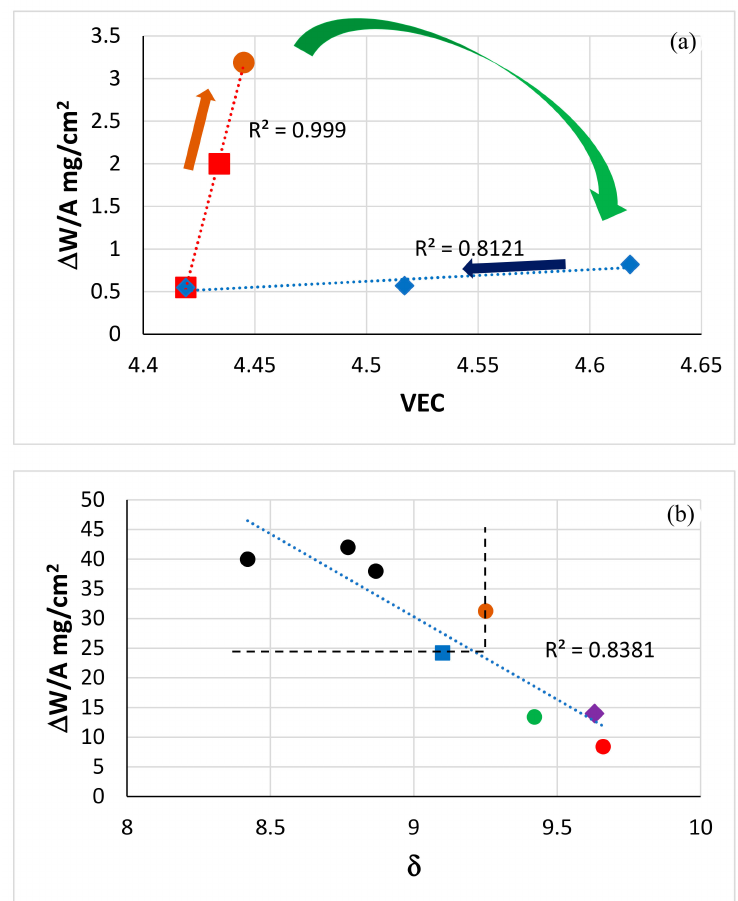
Figure 15. Weight change ∆ W / A versus ( a ) VEC and ( b ) δ at (a) 800 ◦ C and ( b ) 1200 ◦ C. In ( a ) the two lines cross at the data point of the alloy ZF9 [59]. Red ZF9, JG6 [56], orange OHS1 [45], blue ZF9, JZ4 and JZ5. In ( b ) the data are for the alloys ZF6 [59], ZX8 [42], ZF9, OHS1, JZ3, JZ3 + [47], JZ4, JZ5. Red JZ5, green JZ4, square JZ3, diamond JZ3 + , orange OHS1. For all data R 2 = 0.8381, for the alloys OHS1, JZ4 and JZ5 R 2 = 0.8395. For nominal compositions of alloys see Abbreviations. For dashed lines see